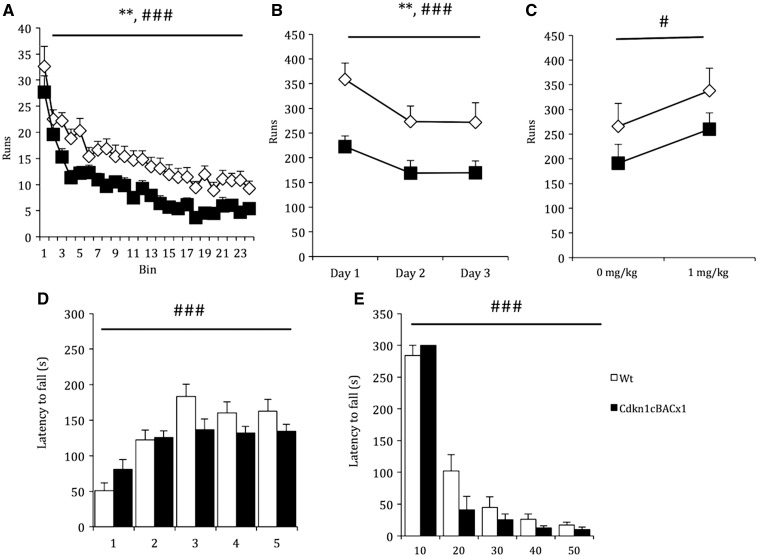
Cdkn1cBACx1 animals display hypoactivity unrelated to any motoric function deficits. (A) Locomotor activity data on the first day of testing broken down into 5-minute bins shows consistent reduced activity of Cdkn1cBACx1 mice relative to WT littermates throughout the session. (B) Cdkn1cBACx1 also displayed consistent hypoactivity across three consecutive test days. (C) All animals showed the expected increase in activity after amphetamine administration. (D) Reduced activity in Cdkn1cBACx1 mice was not related to motoric function deficits as all animals increase time before first fall following successive rotatod training session. (E) Similarly, there was no effect of genotype on latency to fall from an accelerating rotarod across a range of test speeds. Data shown is ± SEM. Main effect of GENOTYPE, *= P < 0.05, **= P < 0.01; main effect of within subject factors (BIN, SESSION, DOSE, SPEED) #= P < 0.05, ###= P < 0.001.